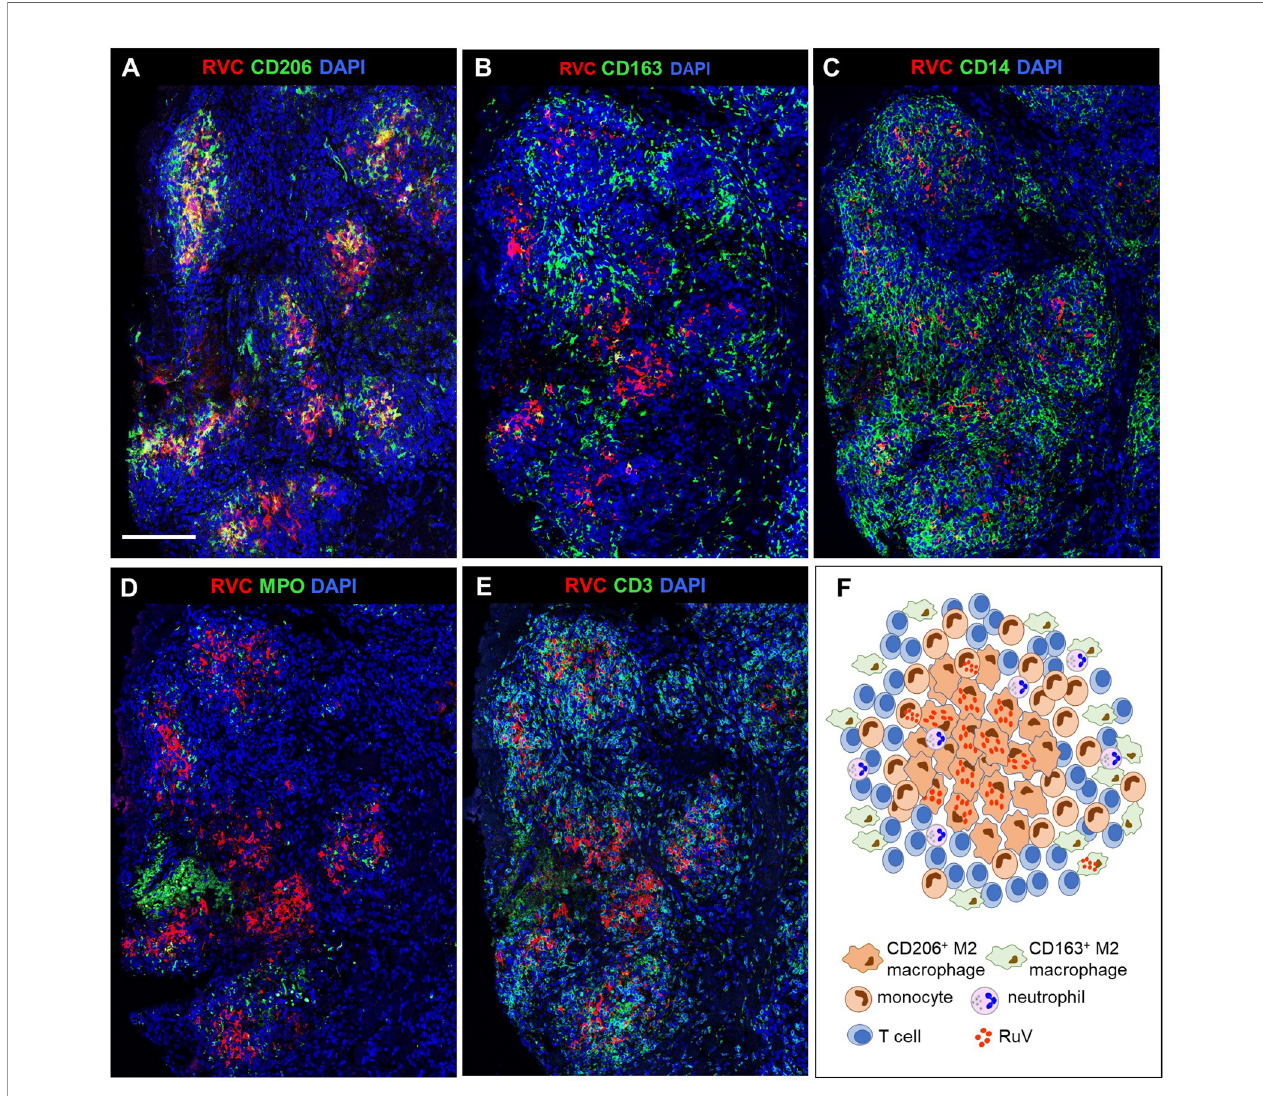
FIGURE 2 | A structure of M-type RuV-associated cutaneous granuloma and its cellular elements. Histological double immuno fl uorescent staining of sequential tissue sections (P18) for RVC (red) and one of the cell type markers (green) shows the presence of RVC predominantly in CD206 + M2 macrophages (A) and infrequently in CD163 + M2 macrophages (B) , CD14+ monocytes (C) and in sporadic MPO+ neutrophils (D) . Layers of many RVC - CD3 + T cells surround RVC + / CD206 + granuloma centers (E) . Scale bar: 200 µm. Schematic of M-type RuV-associated granuloma pattern (F)